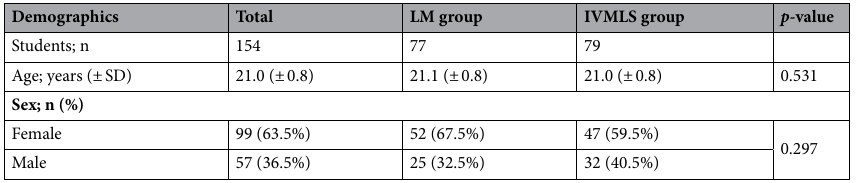
Table 1. Descriptive data of participants enrolled in this study. LM light microscope, IVMLS interactive virtual microscope laboratory system, n number of students.